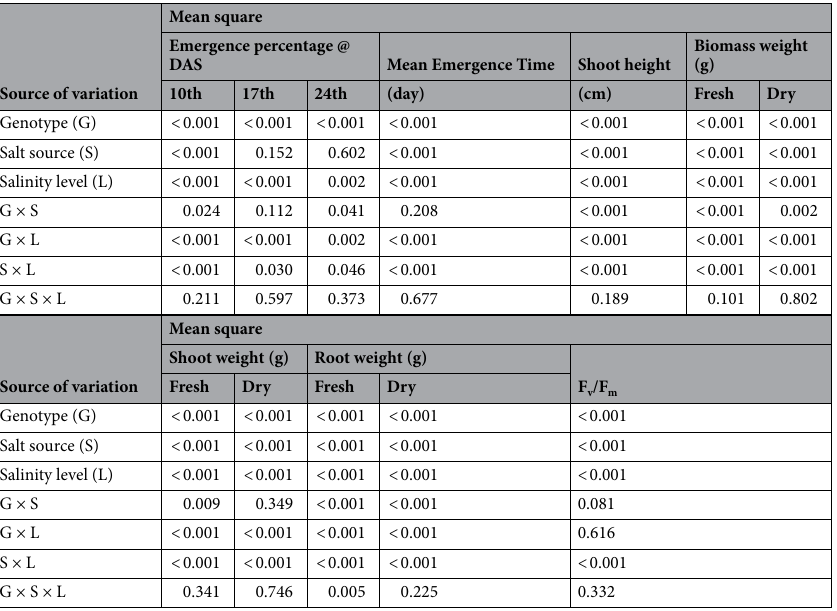
Table 1. P values (significance) from analysis of variance for the effects of faba bean genotype, salt source and salinity level on investigated